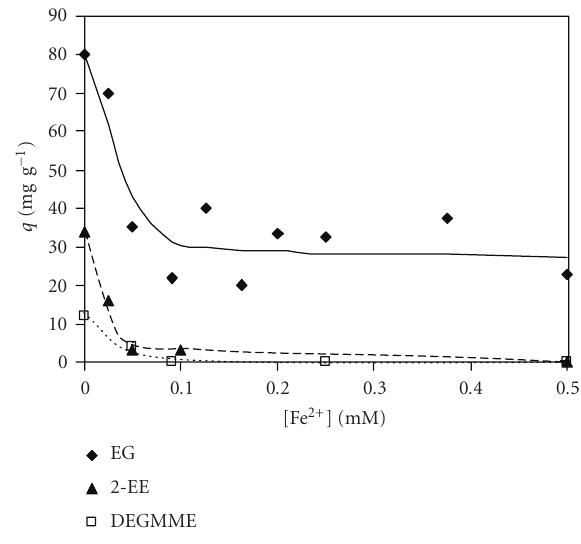
Figure 4: The surface concentrations of ethylene glycol (EG), 2-ethoxyethanol (2-EE) and diethylene glycol monomethyl ether (DEGMME) on TiO 2 versus Fe 2+ -ions equilibrium concentration at pH 3 (20 ◦ C).